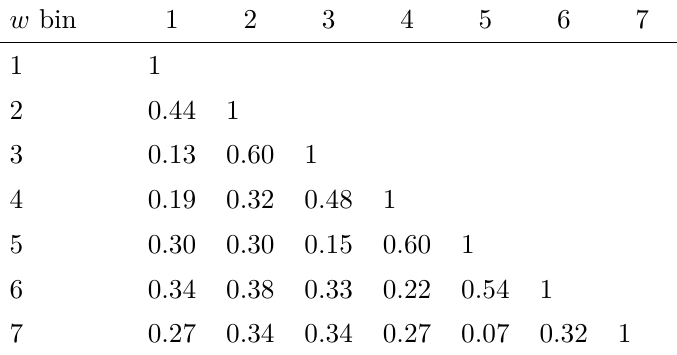
Table 3 . Correlation matrix for the unfolded data set in bins of w , including both statistical and systematic